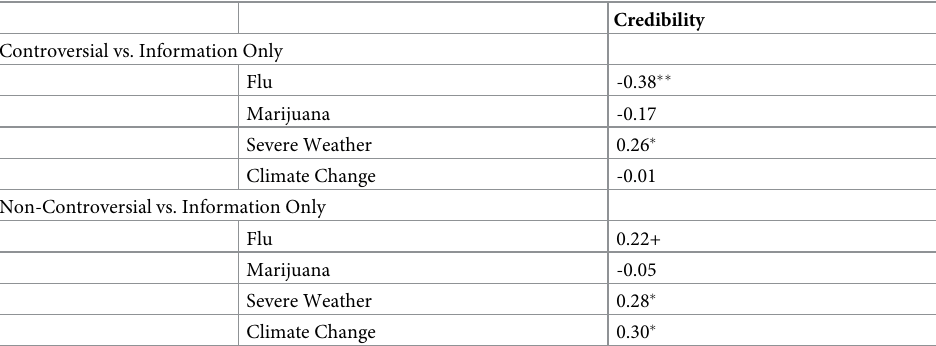
Table 2. Total effects of non-controversial and controversial solutions on credibility, in comparison to the infor- mation only condition. Controversial vs. Information